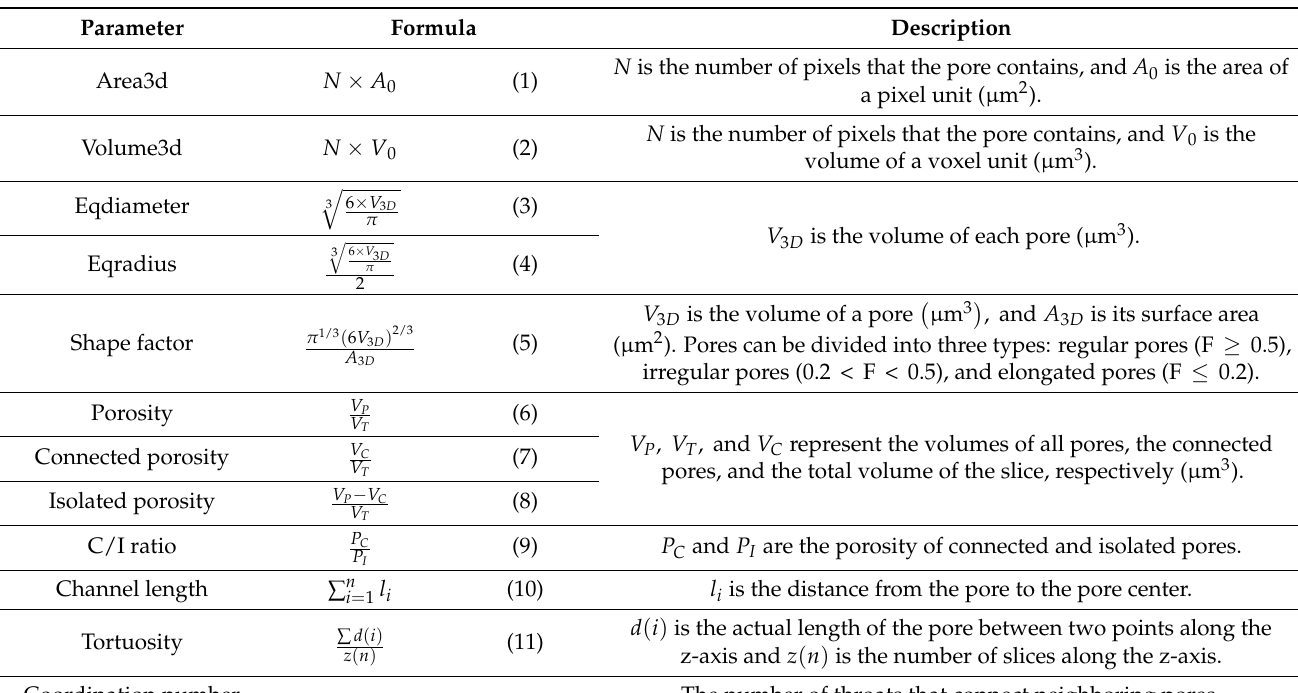
Table 3. Parameter descriptions [27].